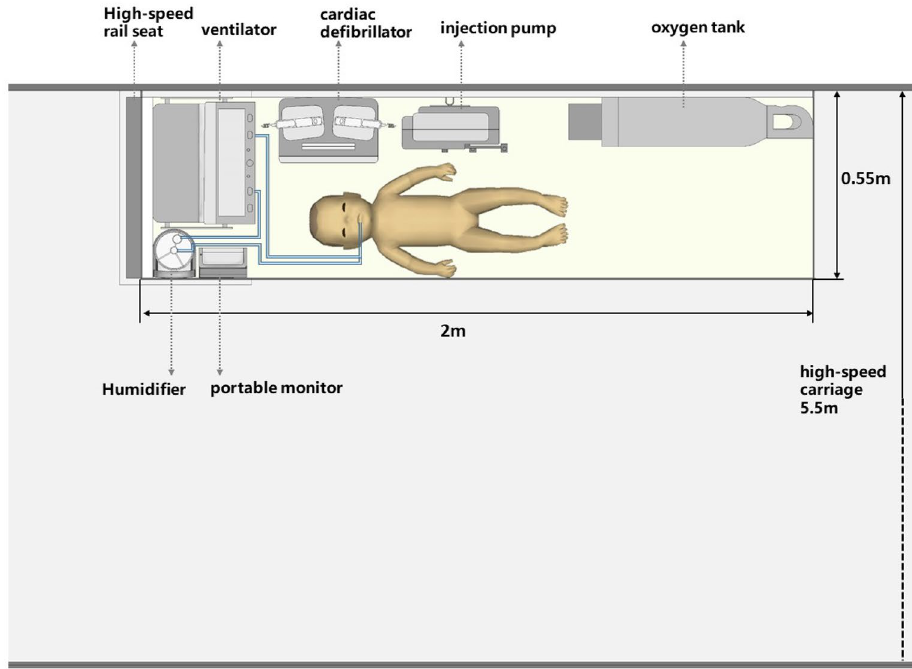
Figure 1. Floor plan of HST carriage during critically-ill children transportation. The transport stretcher, 0.55 m wide and 2 m long, is placed behind the business class seat. Equipment placement are shown in the figure, including a ventilator, monitor, infusion pump, oxygen pipe,